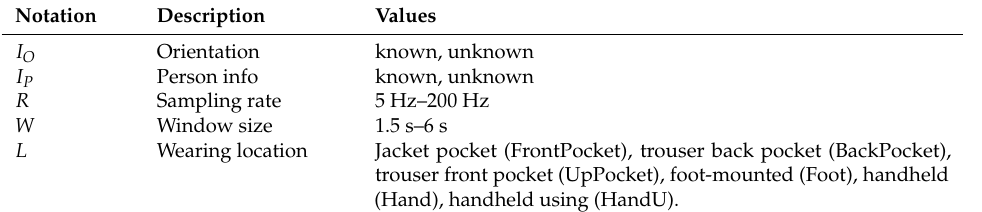
Table 1. Notations and description of context